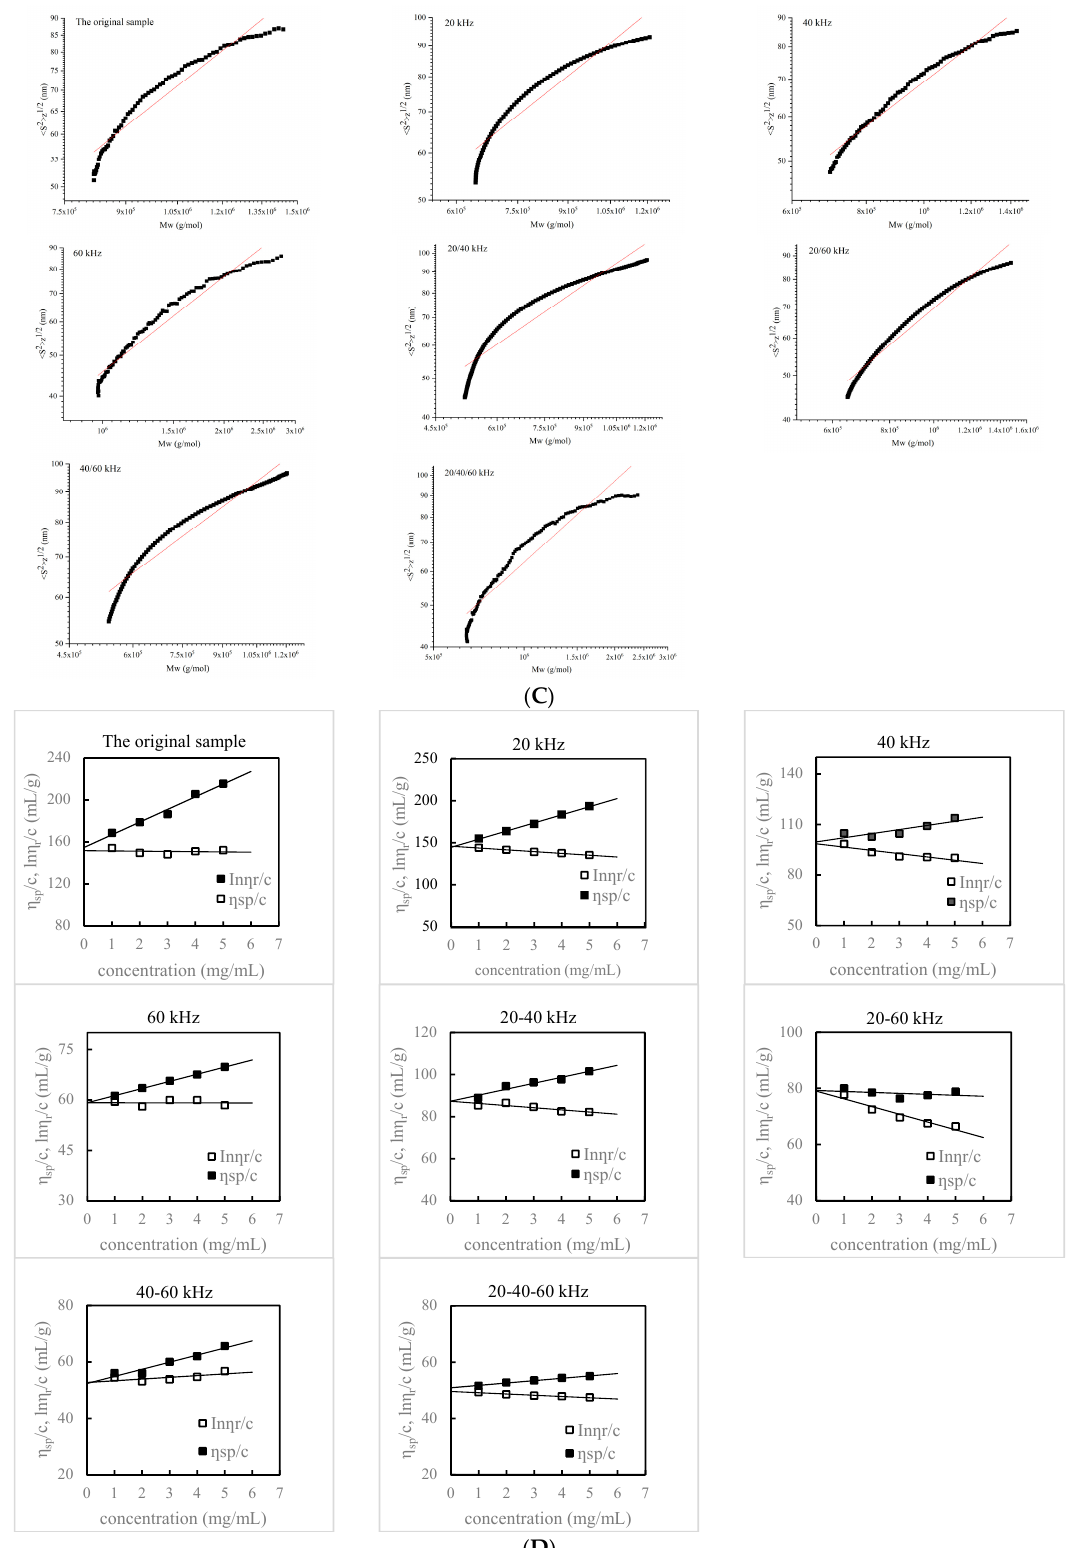
Figure 3. Changes in absorption maximum ( λ max) of Congo red for ultrasound-treated curdlans at various NaOH concentrations ( A ); HPSCE chromatograms of lentinan ( B ); logarithmic plot of lentinan M w versus R g ( C ); dependence of η sp /c and ln η r /c on concentration c ( D